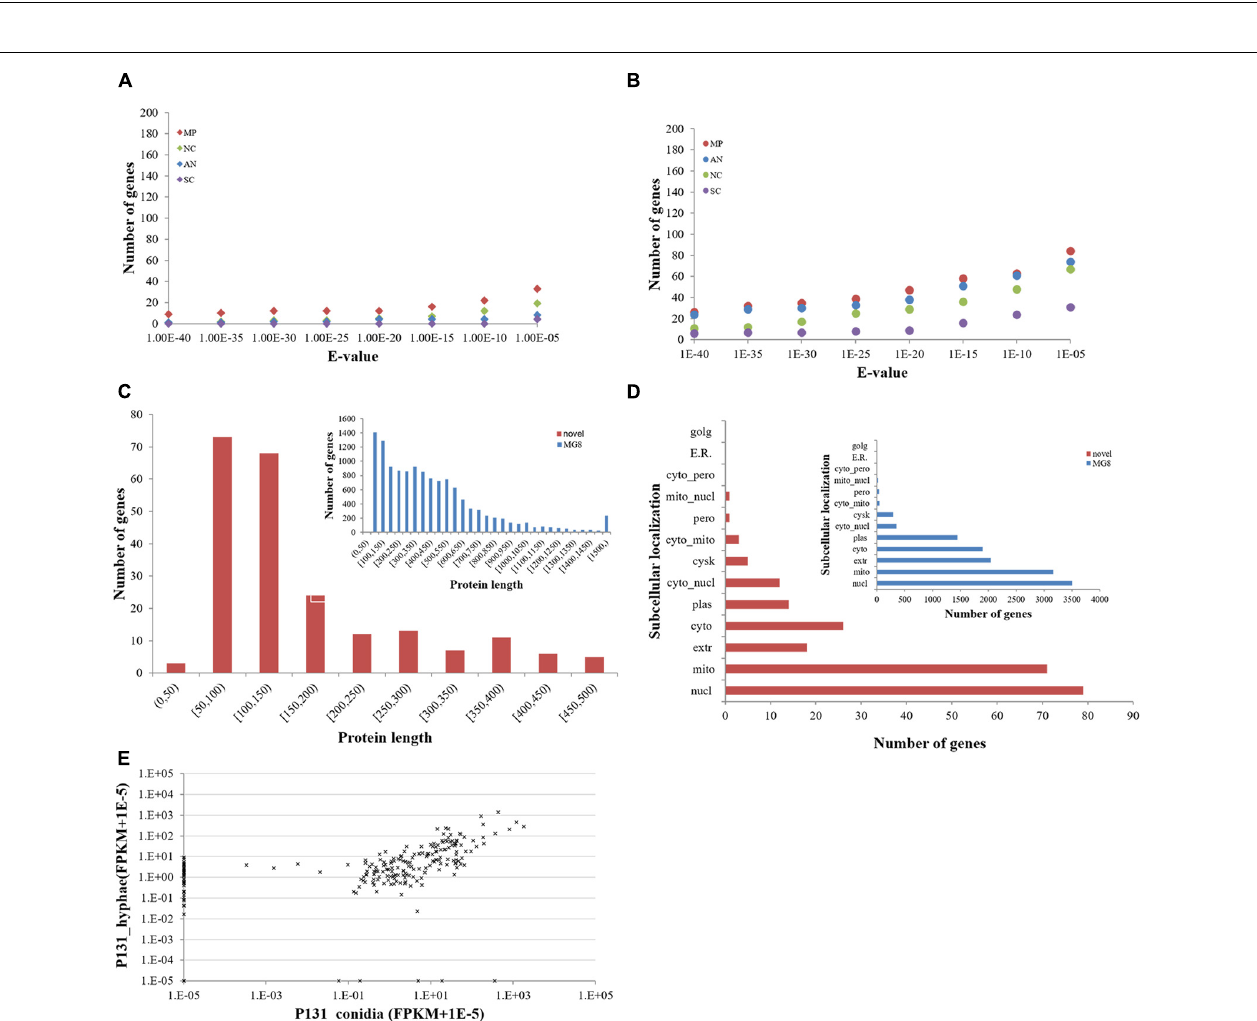
FIGURE 3 | Features of novel protein-coding genes identified in this study. (A) The number of novel Pyricularia oryzae proteins with orthologs in other filamentous ascomycetes by BLASTN and (B) TBLASTN searches. MP, Magnaporthe poae ; AN, Aspergillus nidulans ; NC, Neurospora crassa ; SC, Saccharomyces cerevisiae . (C) Length distribution and (D) subcellular localizations of novel P. oryzae proteins compared with those of proteins present in the MG8 annotation (inlets). (E) Expression levels of novel P. oryzae protein-coding genes (represented by FPKM) in conidia and hyphae.